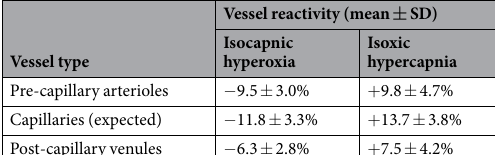
Table 3. Summary of mean ± SD proportional changes in vessel diameter measured in “responders” during systemic gas perturbations. Note that the two capillary segments that responded in the opposite direction to expected have not been